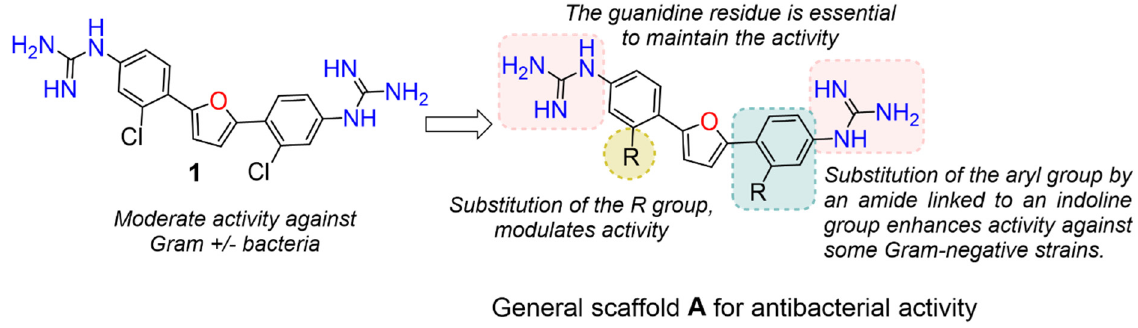
Figure 1. Structure of 2,5-bis(2-chloro-4-guanidinophenyl)furan 1 and structure–activity relationship (SAR) evaluation plan.